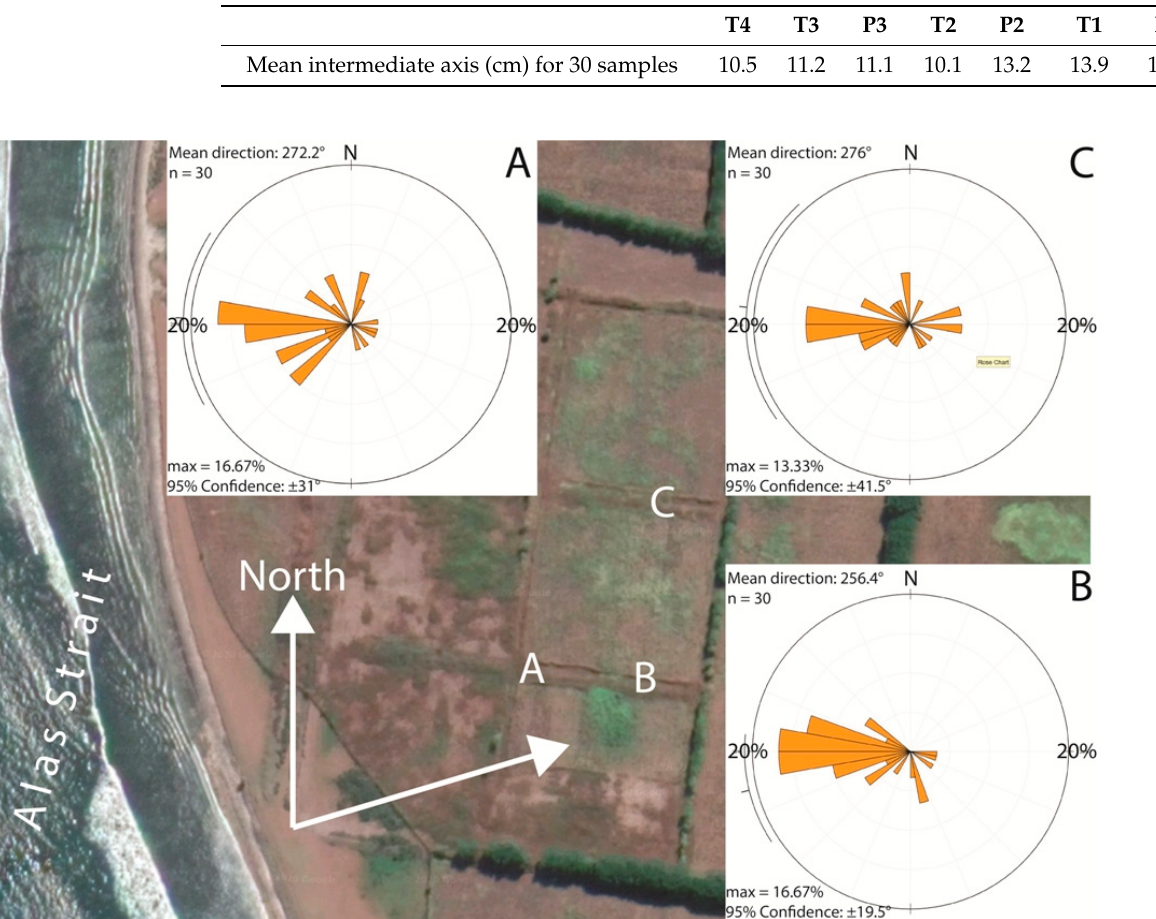
Table 4. Evolution of the sizes of the diameter of pebbles from the sea to the interior in Kiantar Village (see Figure 2d).